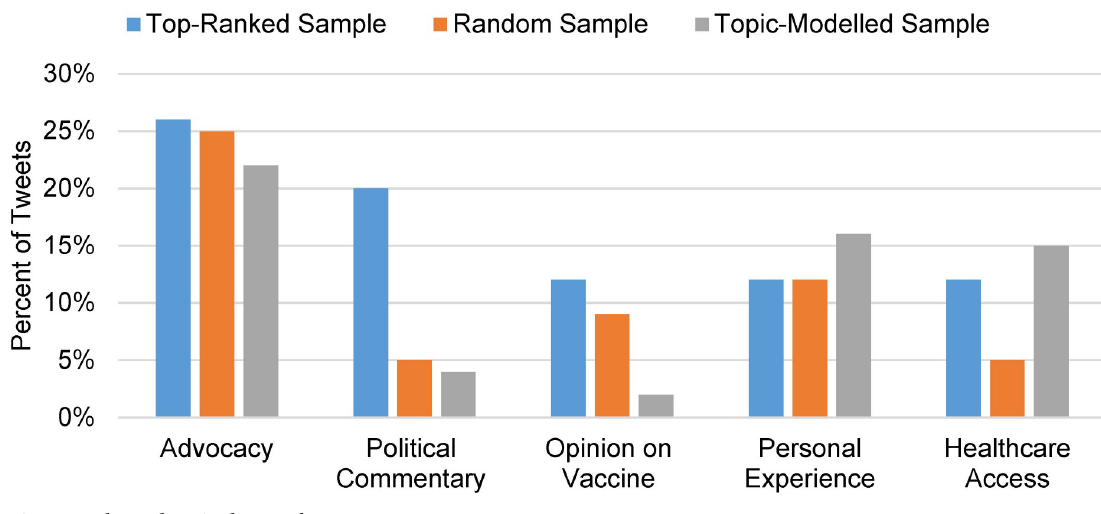
Fig 2. Key theme domains by sample